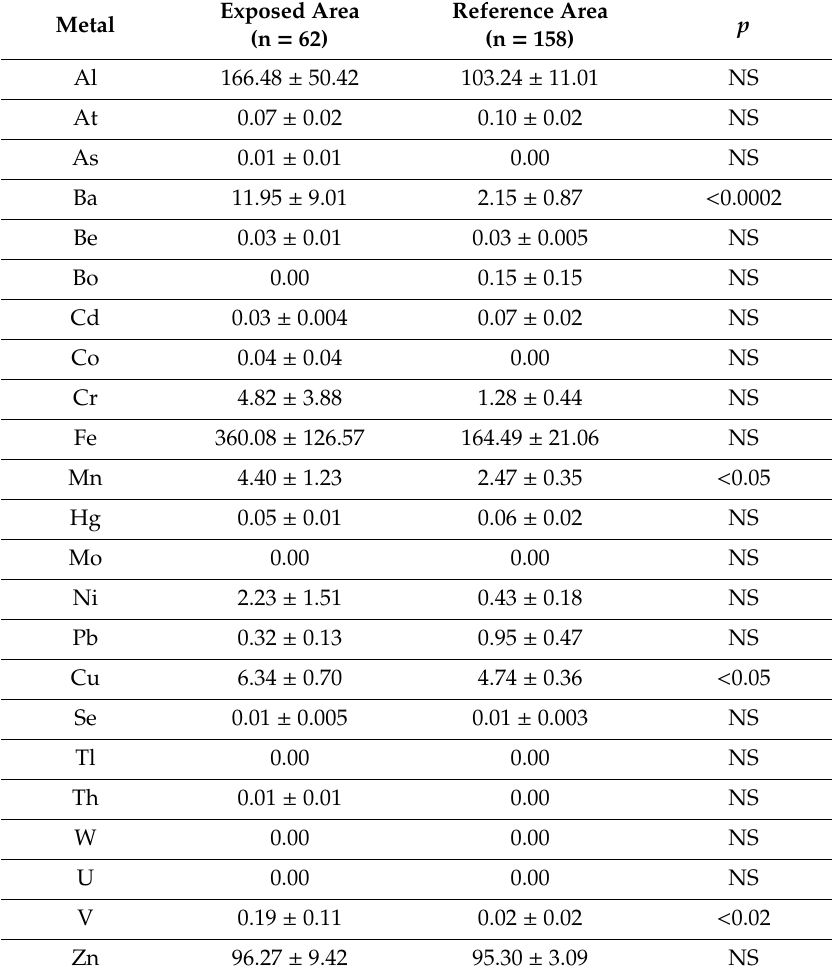
Table 1. Absolute concentrations of metals ( µ g / g) in toenails from children living within a 3 km radius circle around the two incinerators (exposed area) or in the reference